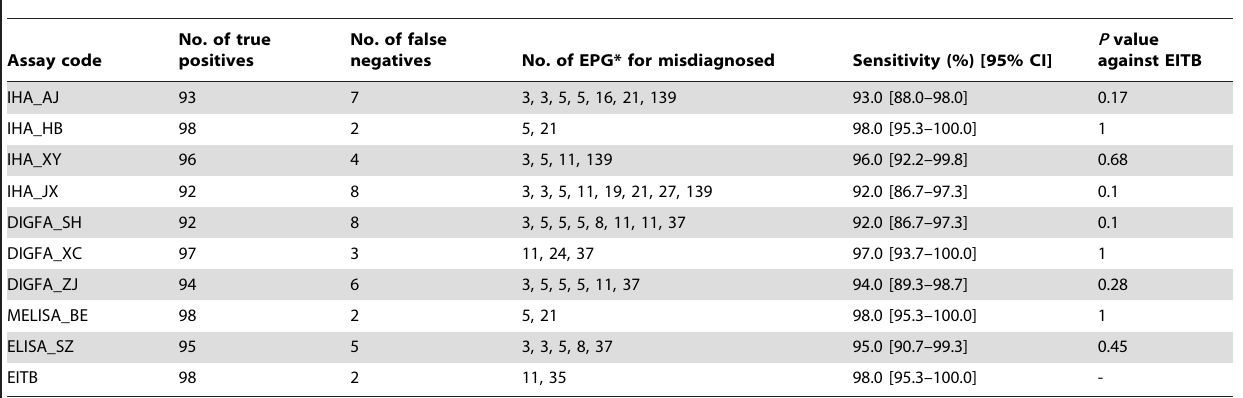
Table 2. Detection of antibodies in S. japonicum egg-positive patients (n= 100).